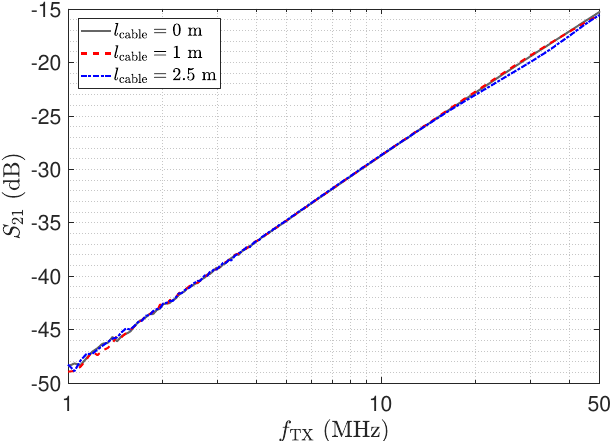
Figure 19. Measurement results for three different cable lengths for the circuit in Figure 17, determined by a network